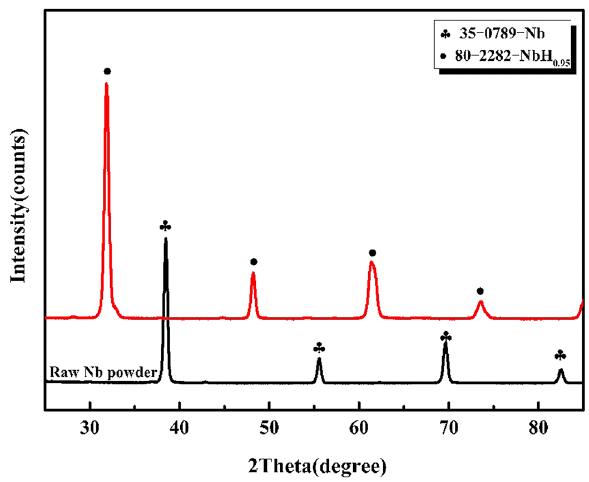
Figure 9. XRD diffraction pattern of niobium powder reduced in hydrogen